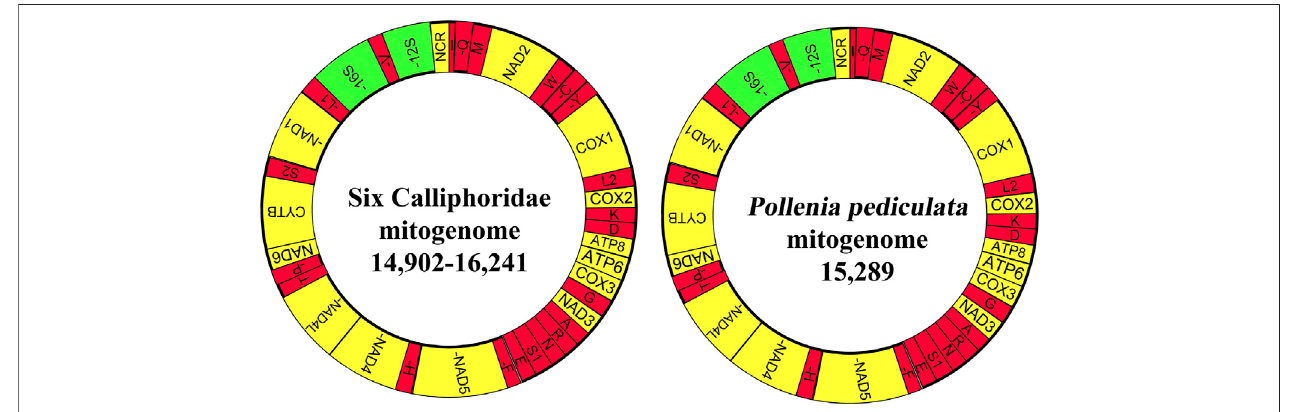
FIGURE 1 | Graphical map of the mitogenome of seven mitogenomes, including sixcalliphorid species and one Polleniidae species. Protein coding and ribosomal RNAgenesareshownusingstandardabbreviations.tRNAsareabbreviated via asingleletter,coveringL1=CUN,L2=UUR,S1=AGN,S2=UCN,andNCR=putative control region. The 13 PCGs and control region are yellow, tRNAs are red, and rRNAs are green. Encoding genes in the N-strand are marked with dashes ( −